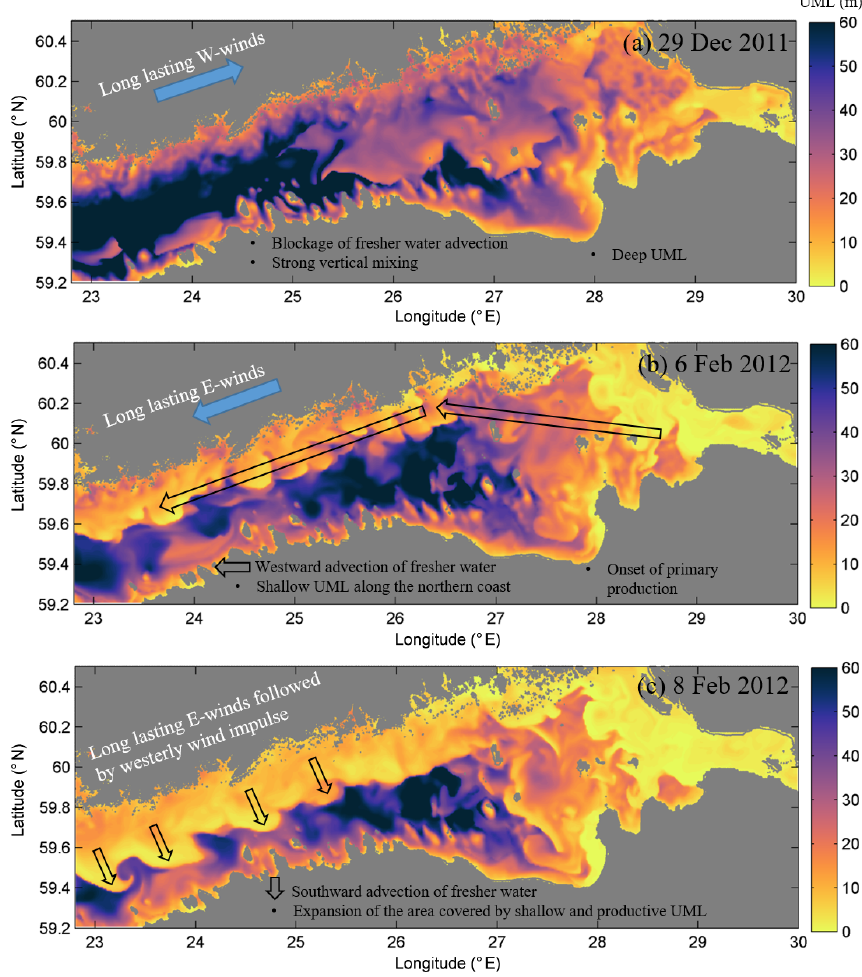
Figure 11. Upper mixed-layer depth (m) based on model simulation data in the Gulf of Finland on (a) 29 December 2011, (b) 6 February 2012, and (c) 8 February 2012. Strong westerly winds dominated before 29 December 2011. Easterly winds prevailing before 6 February 2012 were followed by a westerly wind impulse (see Fig.